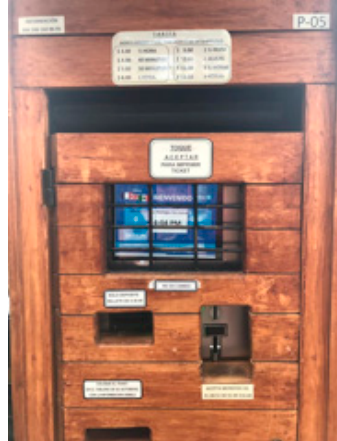
Figure 26. Interface of parking meter in Tlaxcala, Mexico. The hardware is inside a wooden box with steel bars partially covering the screen.